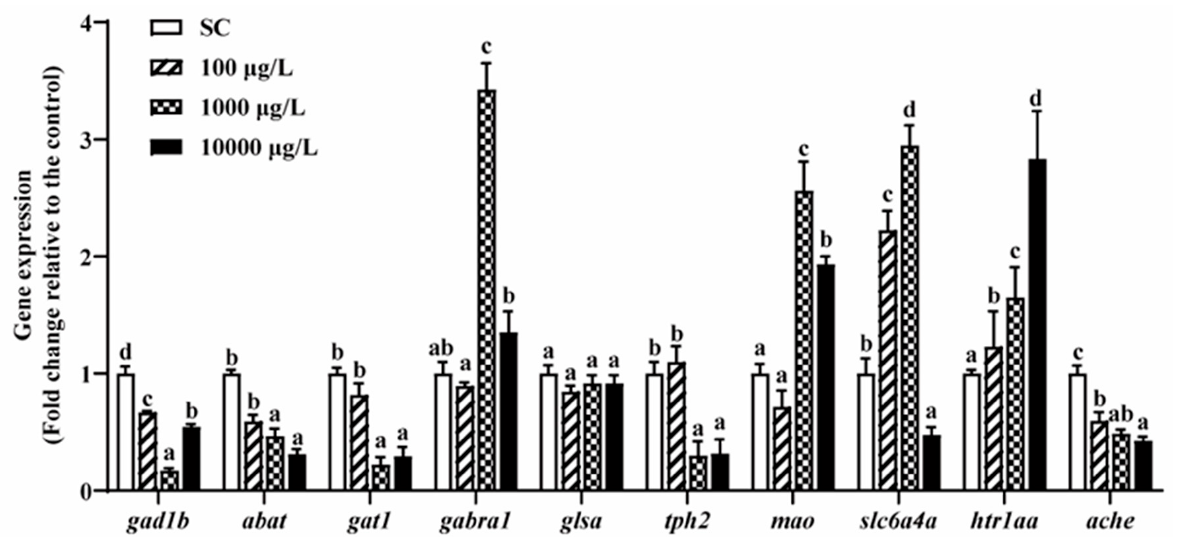
Figure 6. The expression of GABA-, 5-HT-, and AChE-related genes in zebrafish larvae after THCP exposure. One-way ANOVA followed by Tukey’s post hoc tests were used to determine statistical differences. Different letters indicate significant differences between different treatment groups ( p < 0.05).